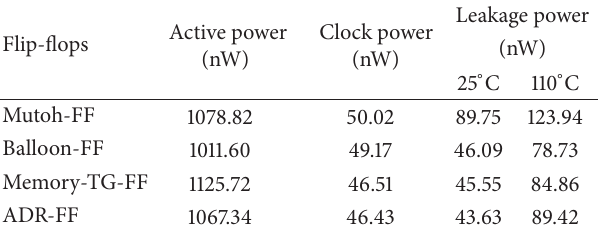
Table 3: Total active power, clock power, and leakage power dissipation of different